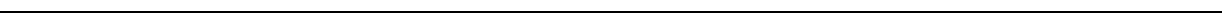
Fig. 1 LIMB allows murine long bone imaging in various locations with high resolution. a Design and positioning of LIMB implant for longitudinal bone marrow imaging. The LIMB implant is fi xed onto the femur using bi-cortical angle-stable screws. GRIN lens systems are placed within the endoscope tubing for imaging and sealed to ensure sterility. The positioner allows adjustment and alignment of GRIN and microscope optical axes. b In order to account for tissue heterogeneity, i.e., metaphyseal vs. diaphyseal regions, alternative LIMB designs have been developed. LIMB fi xation with four screws allows higher bone stability after osteotomies. c Tubing lengths of 500 and 700 µ m, respectively, allow access to either peri-cortical or deep marrow regions. d Two GRIN lens systems are used for imaging. The single GRIN lens (upper panel) combines the imaging and objective lens function and is glued into the endoscope tubing. The symmetric triple GRIN lens (lower panel) is exchangeable and a sapphire window seals the endoscope tubing. e 3D fl uorescence image of the bone marrow of a CX 3 CR1:GFP mouse using the single GRIN lens (myeloid CX 3 CR1 + cells ‑ green; vasculature labeled by Qdots ‑ red). The maximum fi eld of view is circular, with 280 µ m diameter. f The PSF was measured on 100 nm beads ( λ em = 605 nm, λ exc = 850 nm) in agarose, using the single GRIN lens. No signi fi cant wave-front distortions affecting the PSF are observed. g Qdots are used to estimate PSF in marrow tissue. They reveal slight resolution deterioration with increasing imaging depth. h 2D fl uorescence images of Qdots-labeled femoral vasculature, 35 days post-surgery, at various z - positions between the surface of the single GRIN lens and 204 µ m tissue depth. They reveal fi ne vascularization in the upper layers and a large blood vessel (~100 µ m diameter) with emerging branches in the deep marrow. i 2D fl uorescence images of femoral vasculature acquired at various depths and time points post-surgery, using the triplet GRIN lens. The tissue at the contact surface with the window is characterized by de novo micro-vascularization, i.e., granulation tissue. Its thickness varies between individuals and decreases over time after implantation. Scale bars = 100 µ